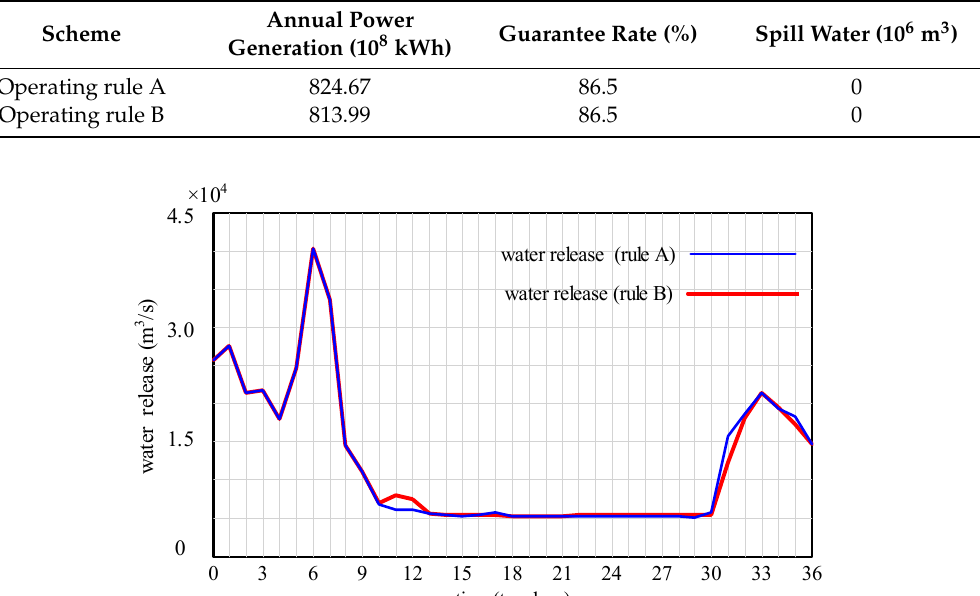
Figure 13. Power output process of TGR decided by operating rules A and B (the operating period is 11 June 2001 to 11 June 2002). Table 3 shows that the annual power generation of operating rule A is larger than that of operating rule B, while the other indicator is not different. This result is explained as follows. As shown in Figures 11–13, in the flood season (from 1-th to 9-th time period), operation results of the two operating rules are the same. However, at the beginning of non-flood season (10-th to 13-th time period), the water release decision of operating rule A is less than that of operating rule B and thus the power output of operating rule A is smaller than that of operating rule B. But rule B will consume the water in the TGR prematurely (in fact, during beginning of non-flood season, the reservoir level is low and such a water release decision is not conducive to power generation) and affect the annual power generation. Finally, at the end of non-flood season (30-th to 36-th time period), the water release decision of rule A is greater than that of rule B, while maintaining a higher water level than that of rule B and so the annual power generation is greater than that of rule B. In short, the decision- making mode of rule A and rule B in flood season is the same but there are differences in non-flood season. At the beginning of the non-flood season, the reservoir water level of TGR is low, rule A keeps a smaller water release decision while rule B keeps a larger water discharge decision. At the end of the non-flood season, the reservoir water level of TGR is high, rule A keeps a greater water release decision while rule B keeps a smaller water discharge decision. Obviously, according to the above discussion, operating rule A is more beneficial to hydroelectric power generation of TGR than operating rule B. That is to say, the most efficient operating rules are identified successfully from given operating rules A and B by SD simulation. 3.3. Discussion of Results